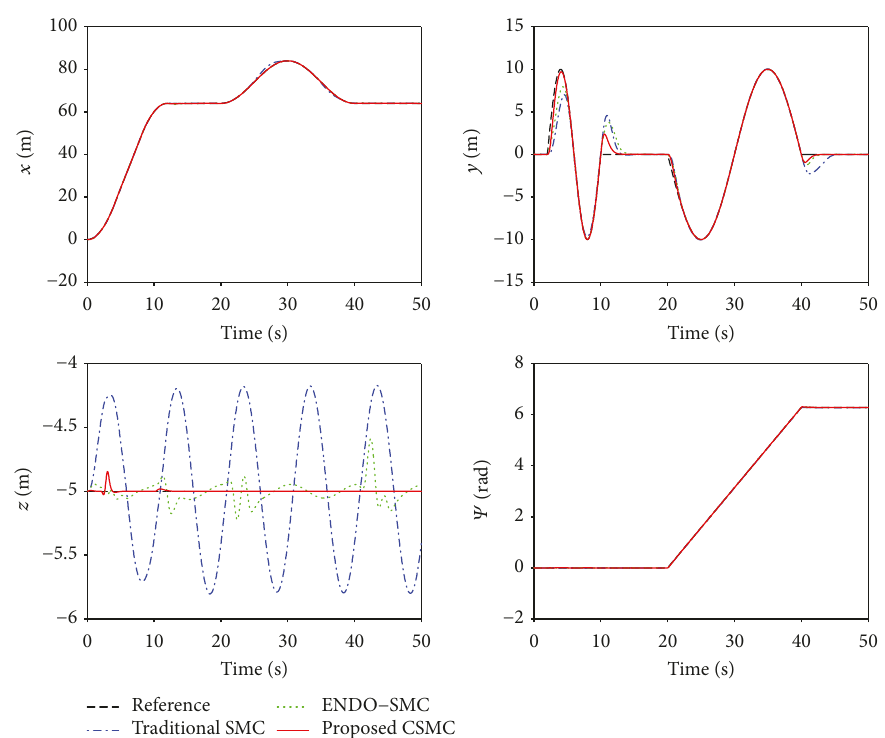
Figure 8: The response curves of position and yaw angle of